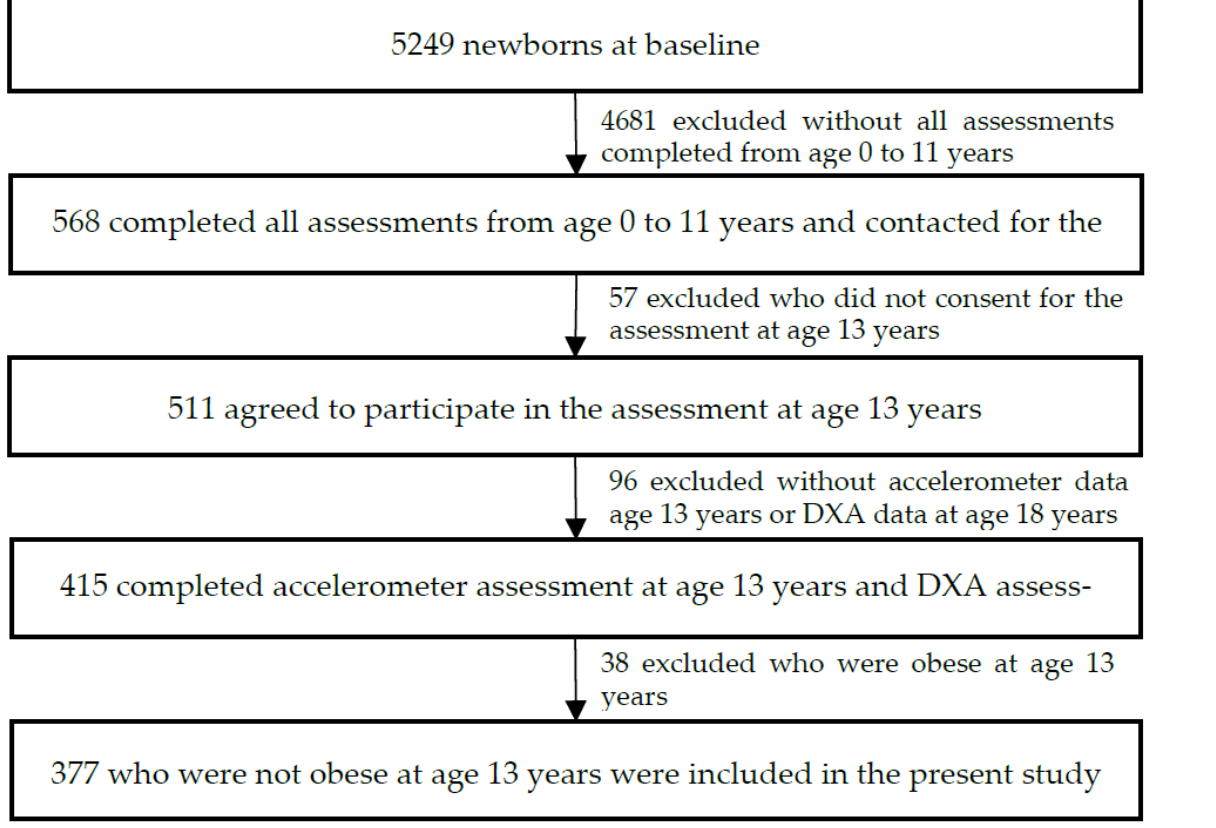
Table 1. Means of MVPA, sedentary time, TV viewing, and FMI according to wealth index quin ‐ tiles among males.